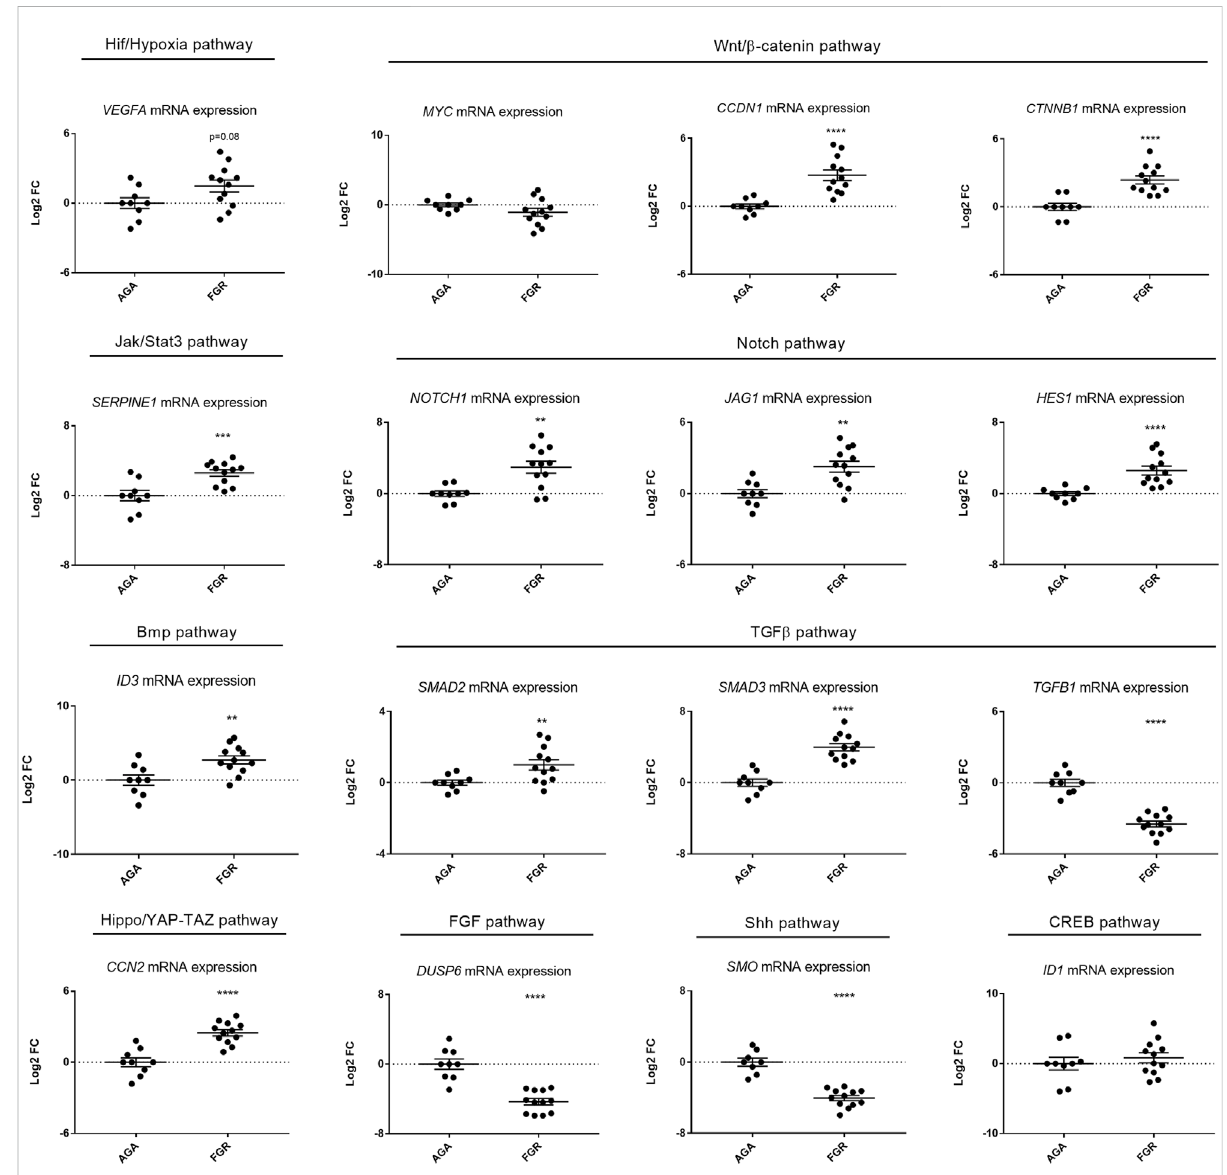
FIGURE 1 Signalling pathway dysregulation in human FGR samples. Quantitative RT-PCR analysis performed on umbilical cords from FGR cases and AGA controls, focusing on ten signalling pathways, identi fi ed signi fi cant upregulation in seven pathways (Hif/Hypoxia, Wnt/ β -catenin, Jak/Stat3, Notch, Bmp, TGF β , Hippo/YAP-TAZ), downregulation in two (FGF, Shh) and no modi fi cation in one (CREB). Sample size: n = 8. * = p < 0.05; ** = p < 0.01; *** = p < 0.001; **** = p < 0.0001, Log2 FC stands for Log2 Fold Change. Test: Unpaired t-test.